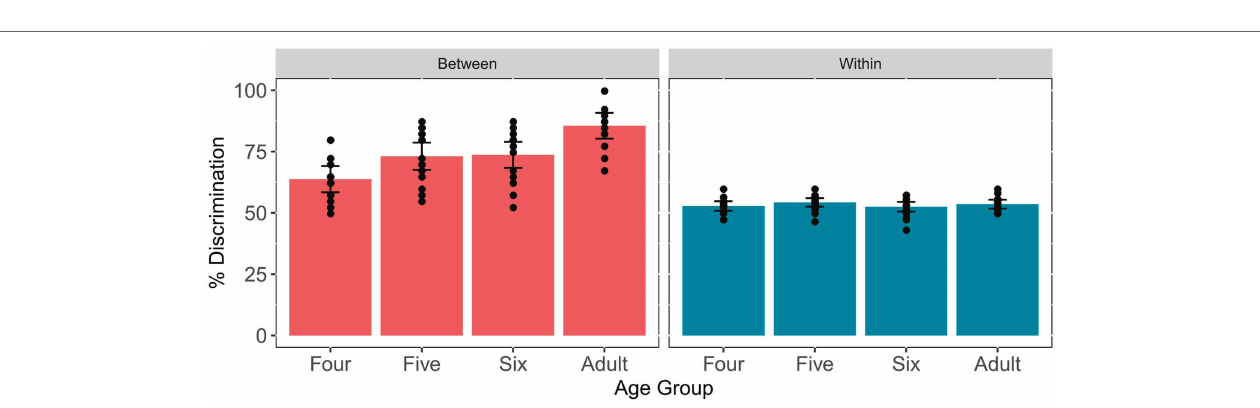
FIGURE 11 | Two-step discrimination scores for the eight pairs in the VOT continuum across age groups.